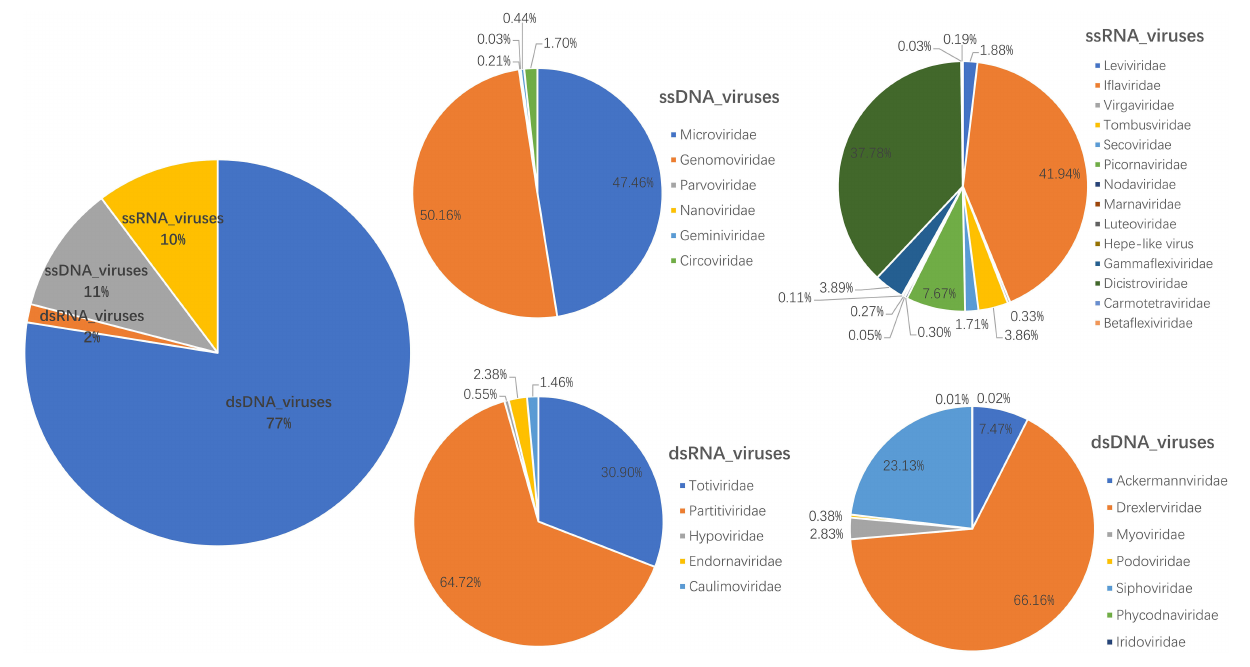
FIGURE 1 | Fecal virome detected in giant pandas. The percentage of virus reads in different virus groups was shown.